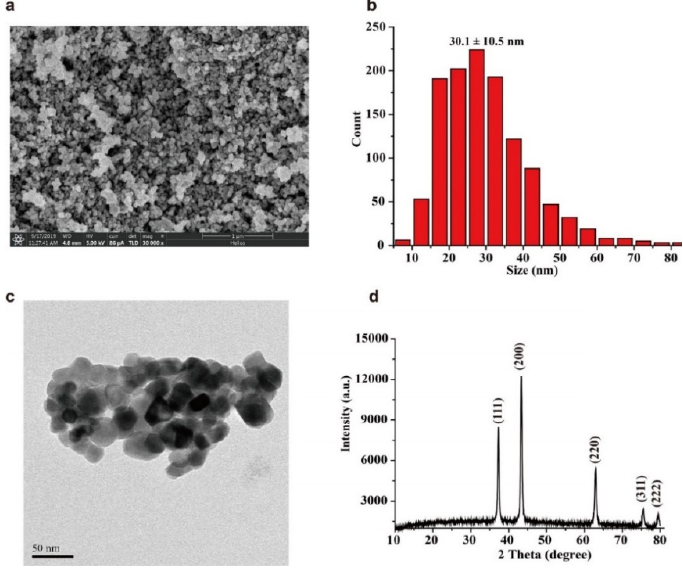
Figure 1. The SEM image ( a ), the particle size distribution histogram ( b ), the TEM image ( c ) and XRD pattern ( d ) of the as-prepared NiO.